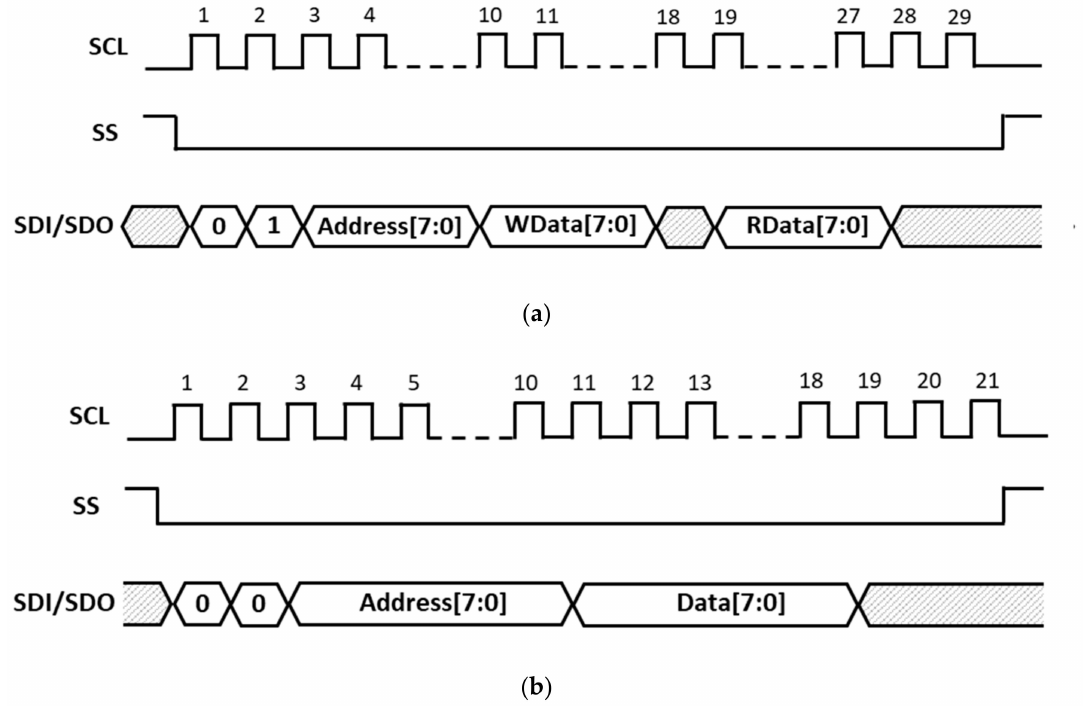
Figure 6. The 3-wire SPI protocol low-cost design operation waveform: ( a ) writing mode; and ( b ) reading